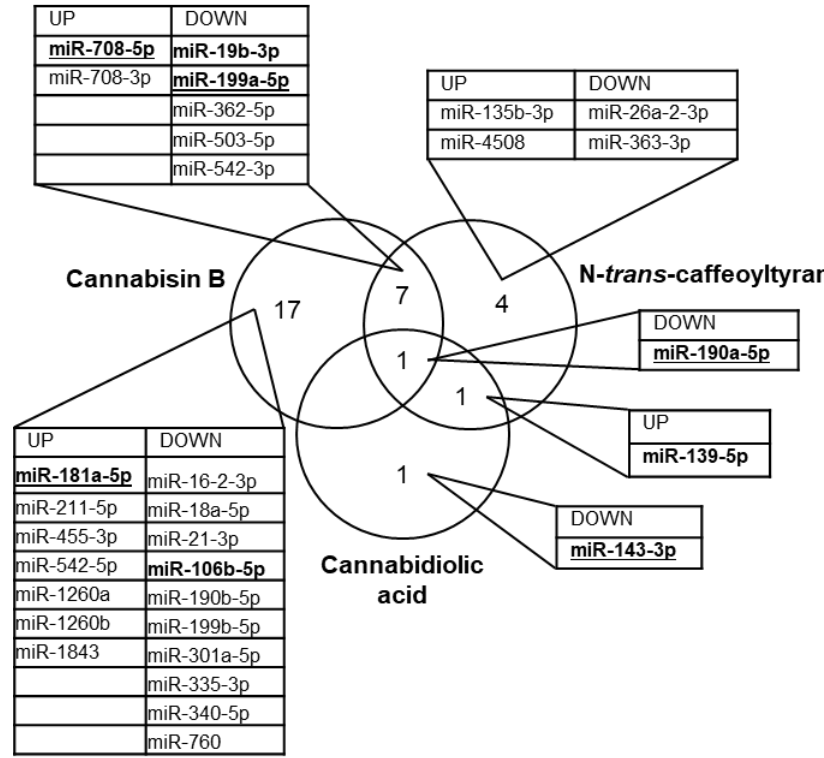
Figure 6. Venn diagram of microRNAs from neural SH cells showing expression levels markedly affected by cannabis compounds. Selection was limited to those microRNAs with an absolute value of log2 fold change ≥ 1. MicroRNAs involved in Alzheimer’s disease are marked in bold; those varying such as to expect an amelioration of neural function in AD are underlined.